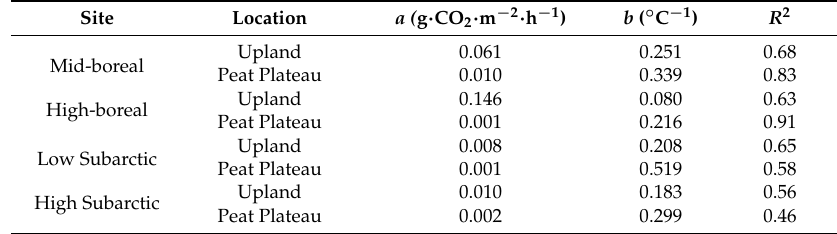
Table 3. Parameter values to estimate the effect of soil temperature T ( ◦ C) at the 5-cm depth on